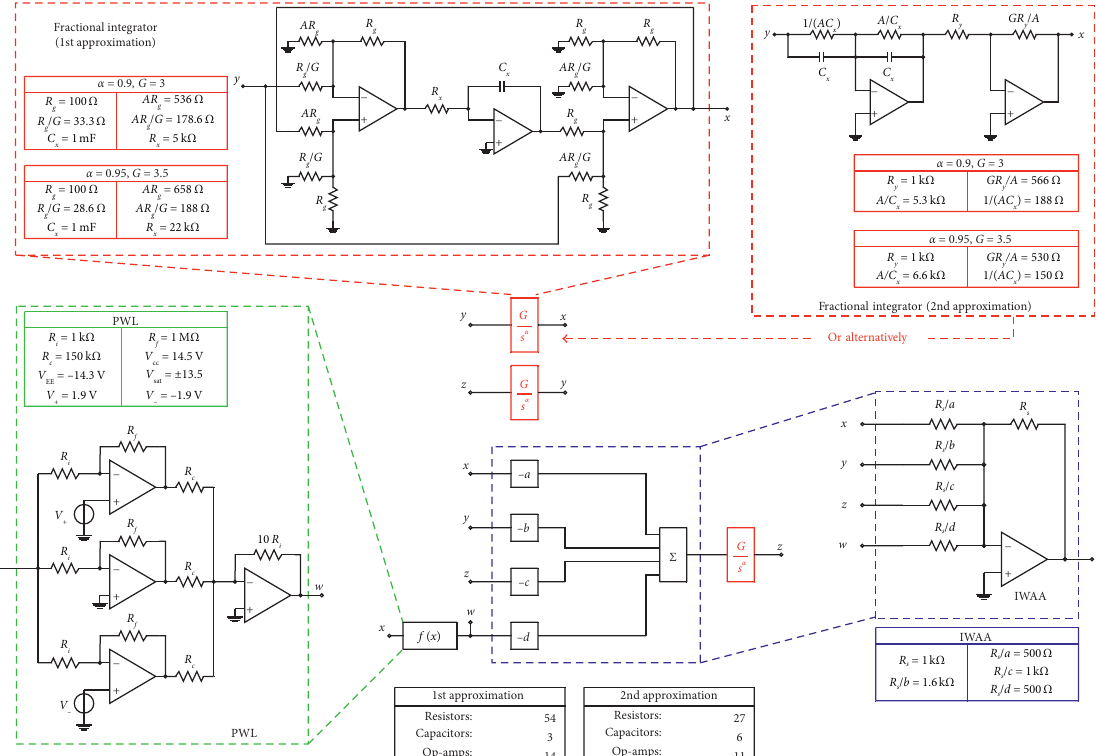
Figure 10: Block diagram and circuit synthesis to realize the fractional-order multiscroll PWL L¨u chaotic system in (20) with α � 0 . 9 and α � 0 .